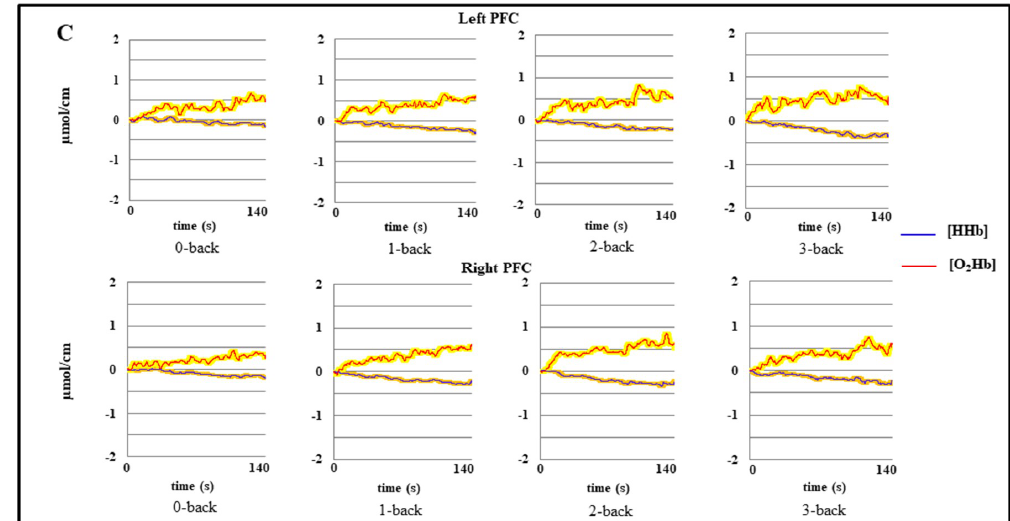
Figure 1. Mean hemodynamic activity as a function of cognitive load, age and hemisphere. ( A ) = Young adults; ( B ) = High-fit older adults; ( C ) = Low-fit older adults. The colored frames on the curves correspond to the standard error of the mean. On the x axe, 0 corresponds to the start of the task + 10 s. and 140 correspond to the end of the task (see text).